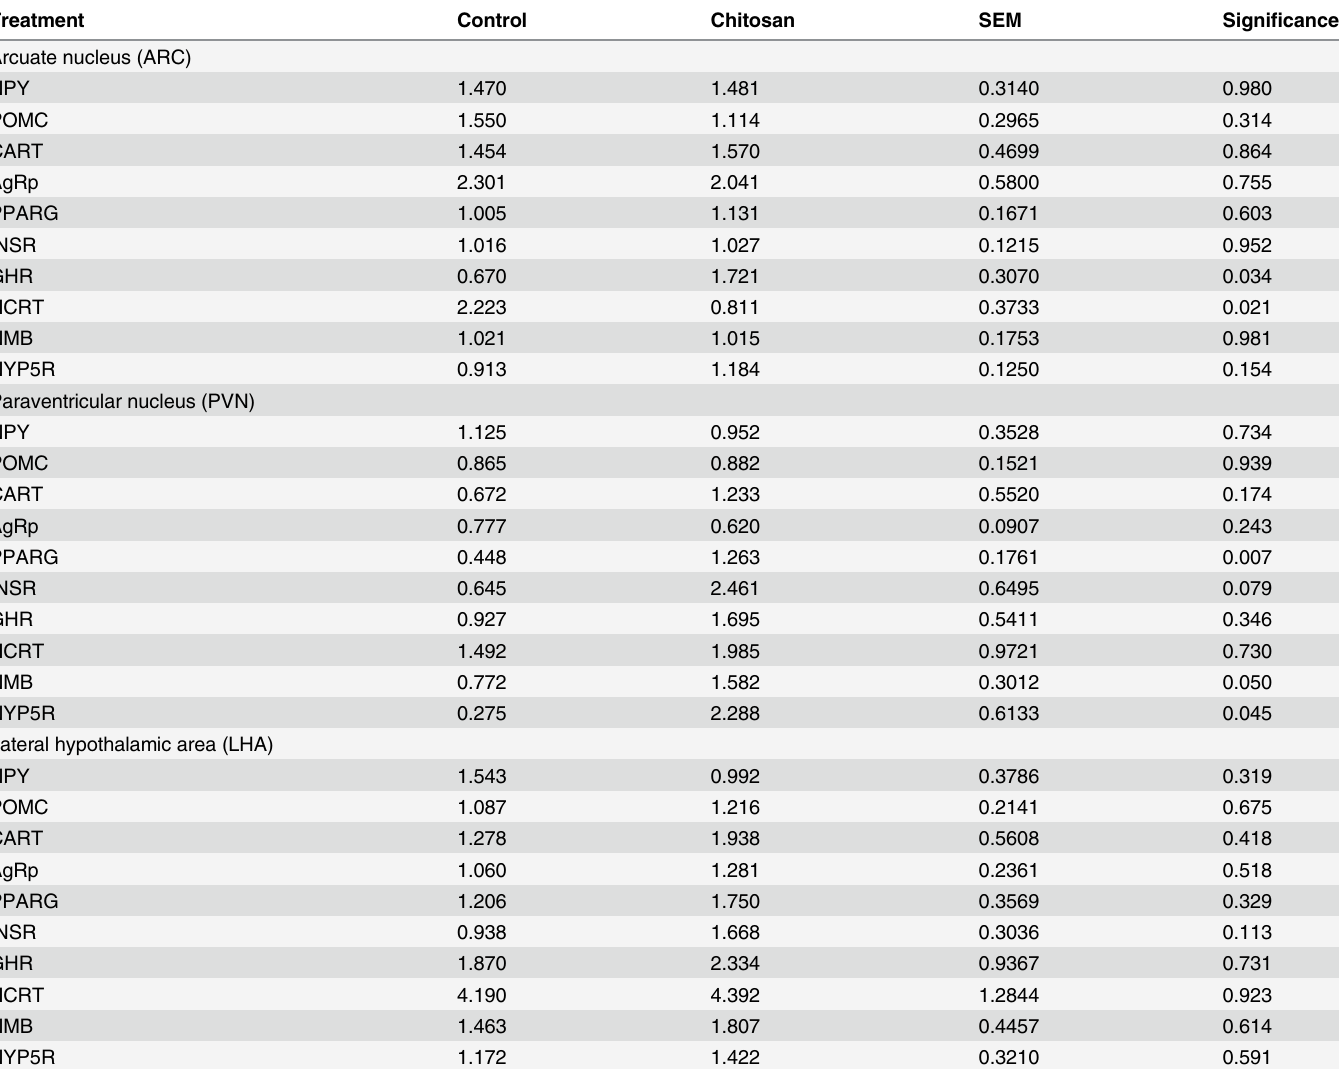
Table 5. Effect of dietary treatment on hypothalamic regulators of appetite in the ARC, PVN and LHA (least square means and SEM).